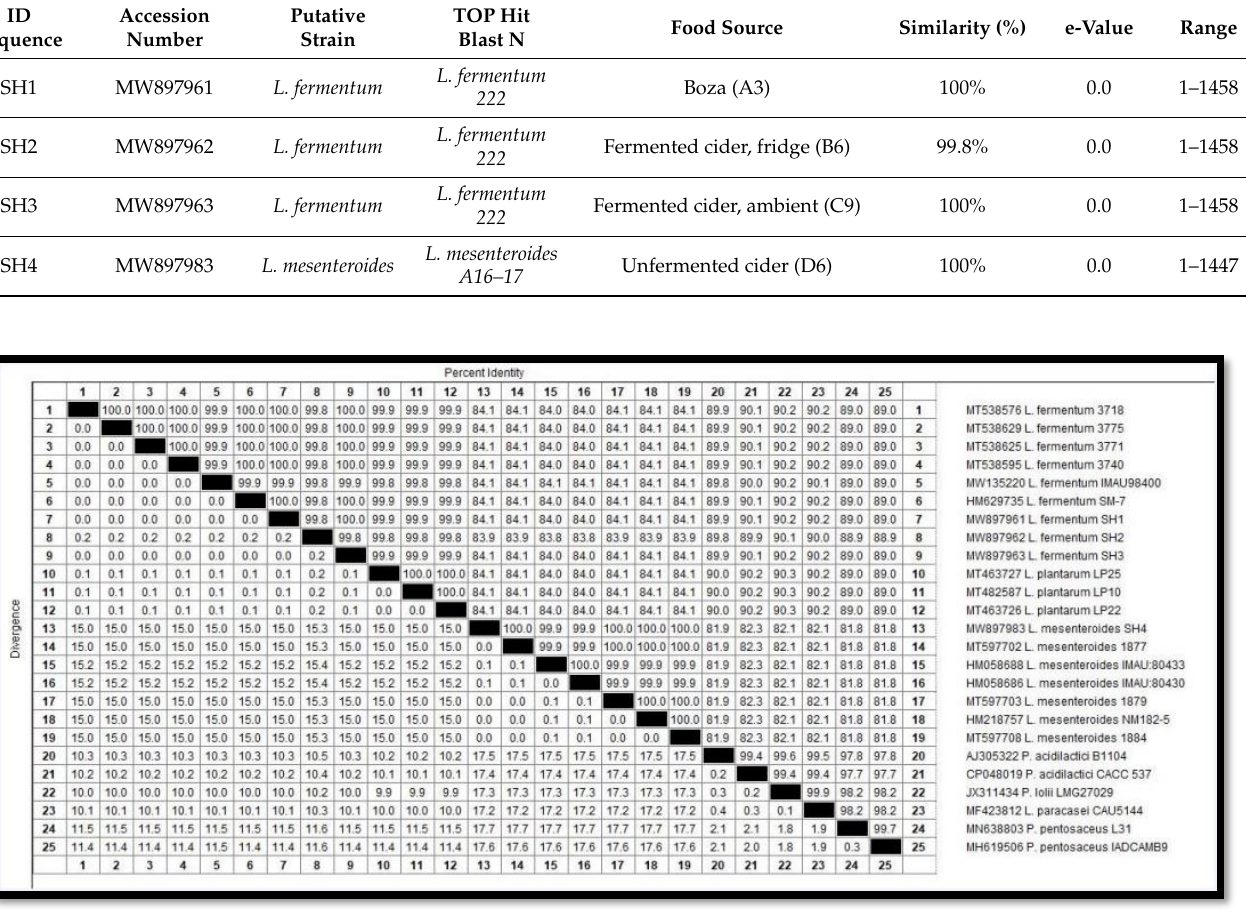
Figure 4. 16S rRNA degree of similarity to the NCBI database for the isolated bacterium indicated with numerals and symbols 7 (SH1), 8 (SH2), 9 (SH3), and 13 (SH4).